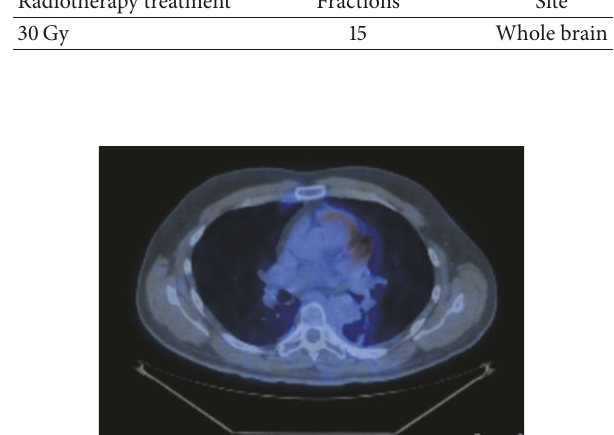
Figure 4: PET scan following palliative radiotherapy now metabol- ically negative. Note after clarification from nuclear medicine radiologist: myocardial uptake is present as patient did not comply with 6-hour glucose fasting prior to